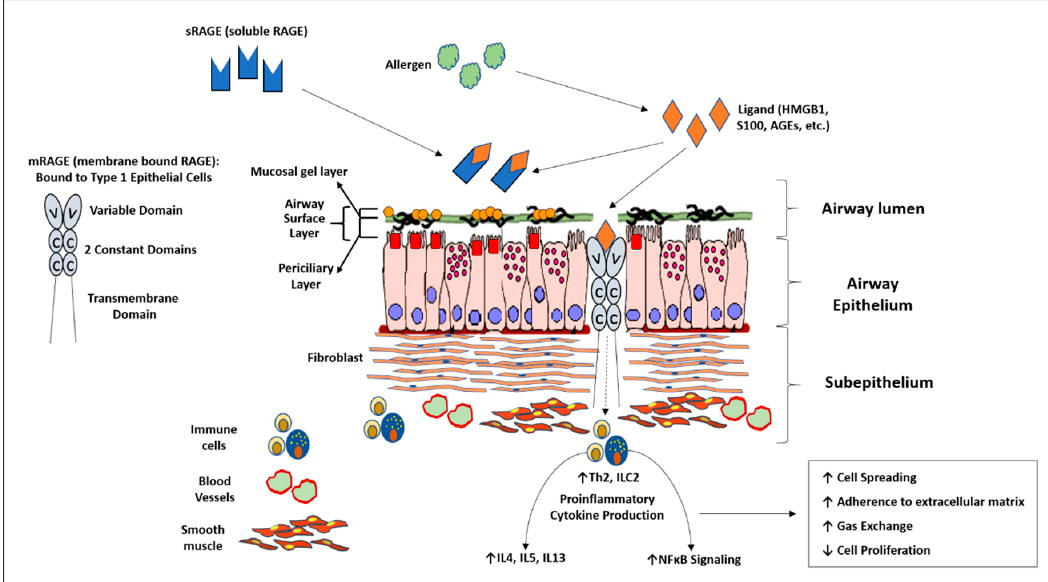
Figure1. Diagramsummarizingthereceptorforadvancedglycationendproducts(RAGE)inflammatory axis within the airway. Membrane bound RAGE (mRAGE) is a transmembrane receptor